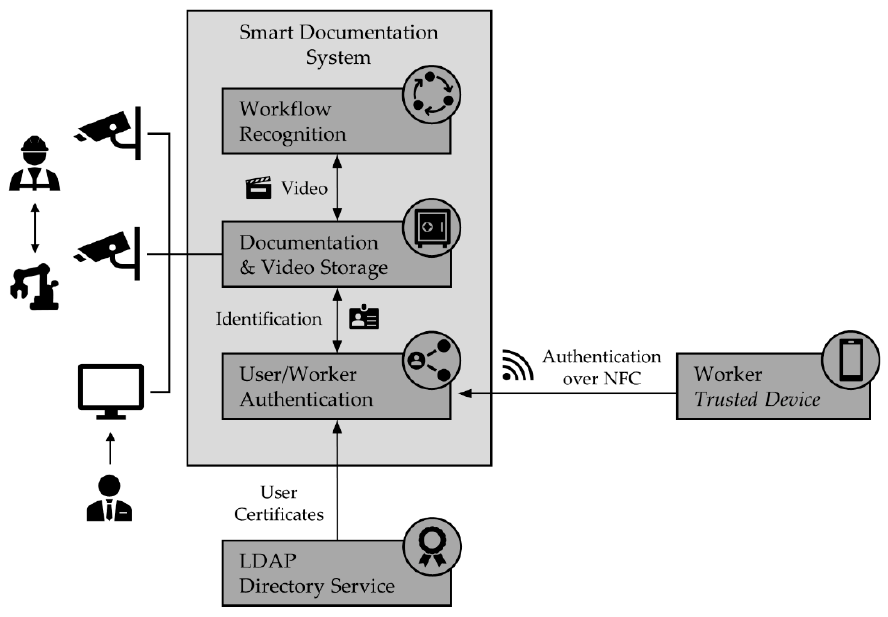
Figure 2. Basic system design.